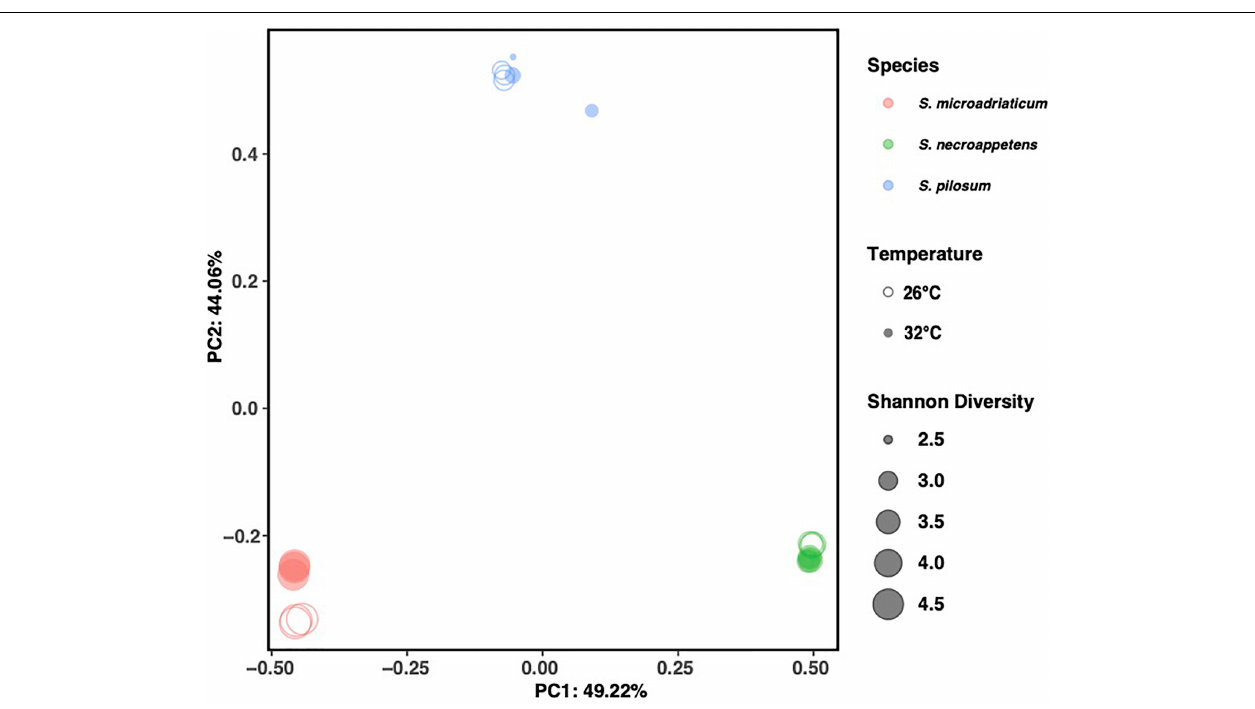
FIGURE 1 | Principal coordinate analysis (PCoA) plot of bacterial communities, with three replicates for Symbiodinium pilosum , Symbiodinium microadriaticum , and Symbiodinium necroappettens under 26 and 32 ◦ C conditions. All data shows strong bacterial assemblages grouped on Symbiodinium species rather than